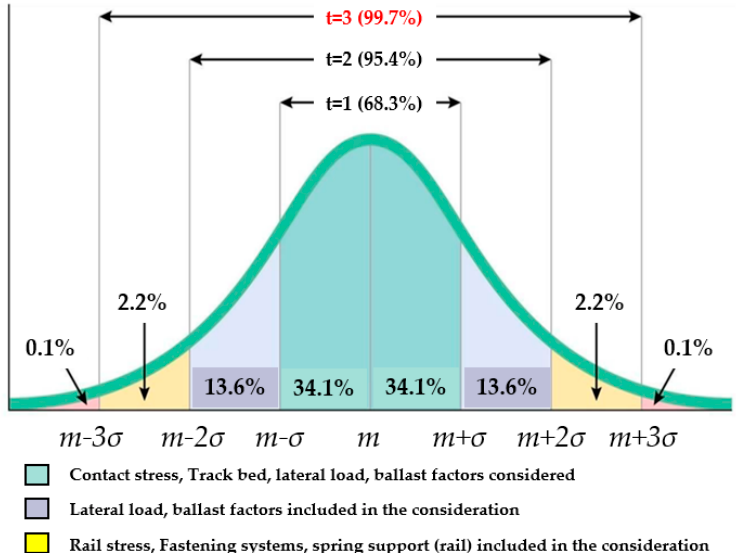
Figure 3. Wheel load fluctuation calculation method and parameter based on standard deviation.